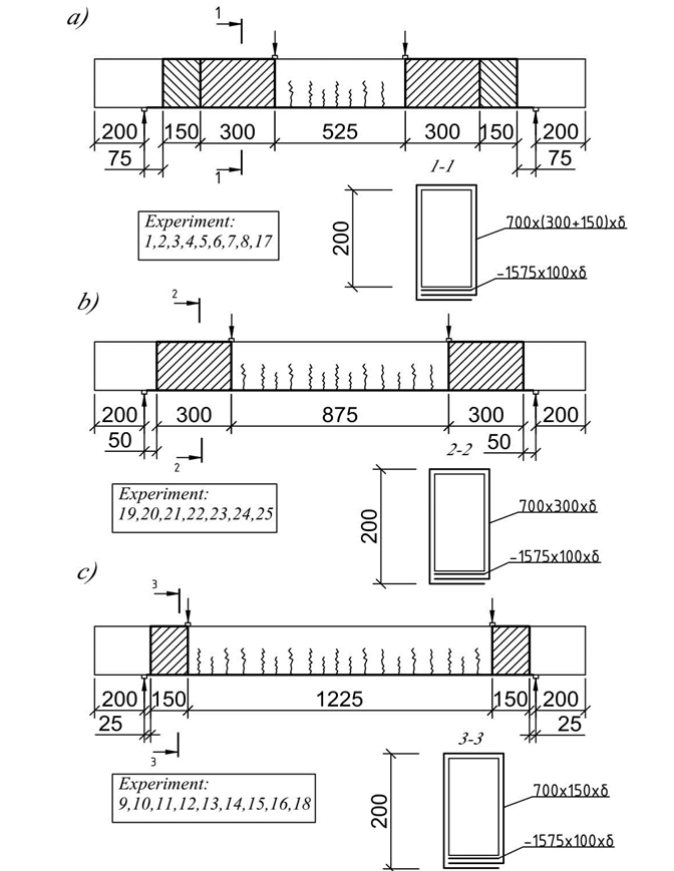
Figure 1. Patterns of strengthening the lower tensioned zones and support areas of the damaged r.c. beams of 3rd series with large (a), medium (b) and small (c) shear spans. The strengthened with external CFRP beams of series 5 were tested according to the same methodology as the beams of series